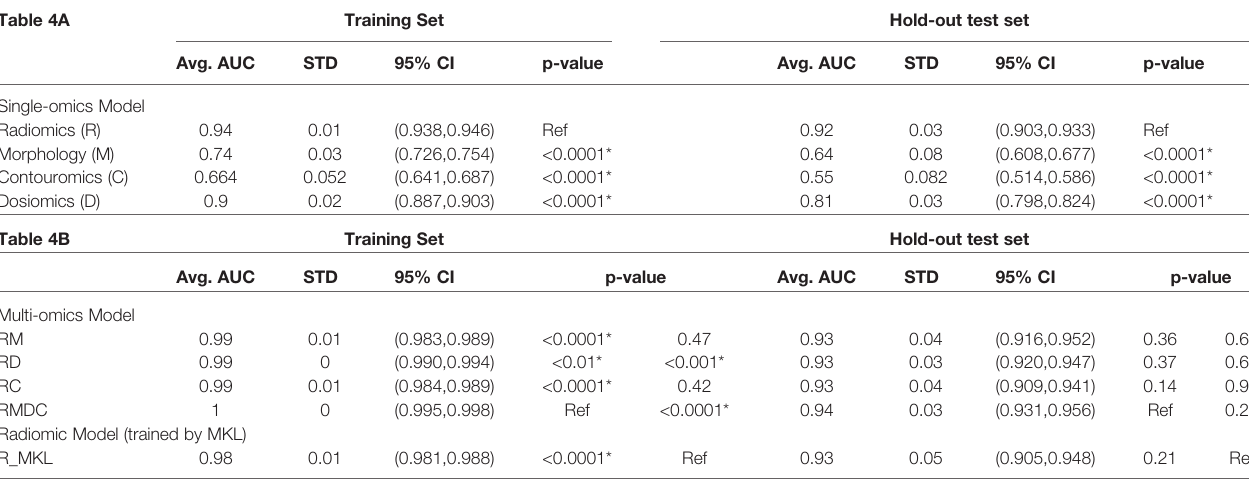
TABLE 4(A-B) | A summary of statistical estimates on performance of single-omics models (4A), multi-omics models and the Radiomic model trained by using MKL algorithm (4B). Table 4A Training Set Hold-out test set